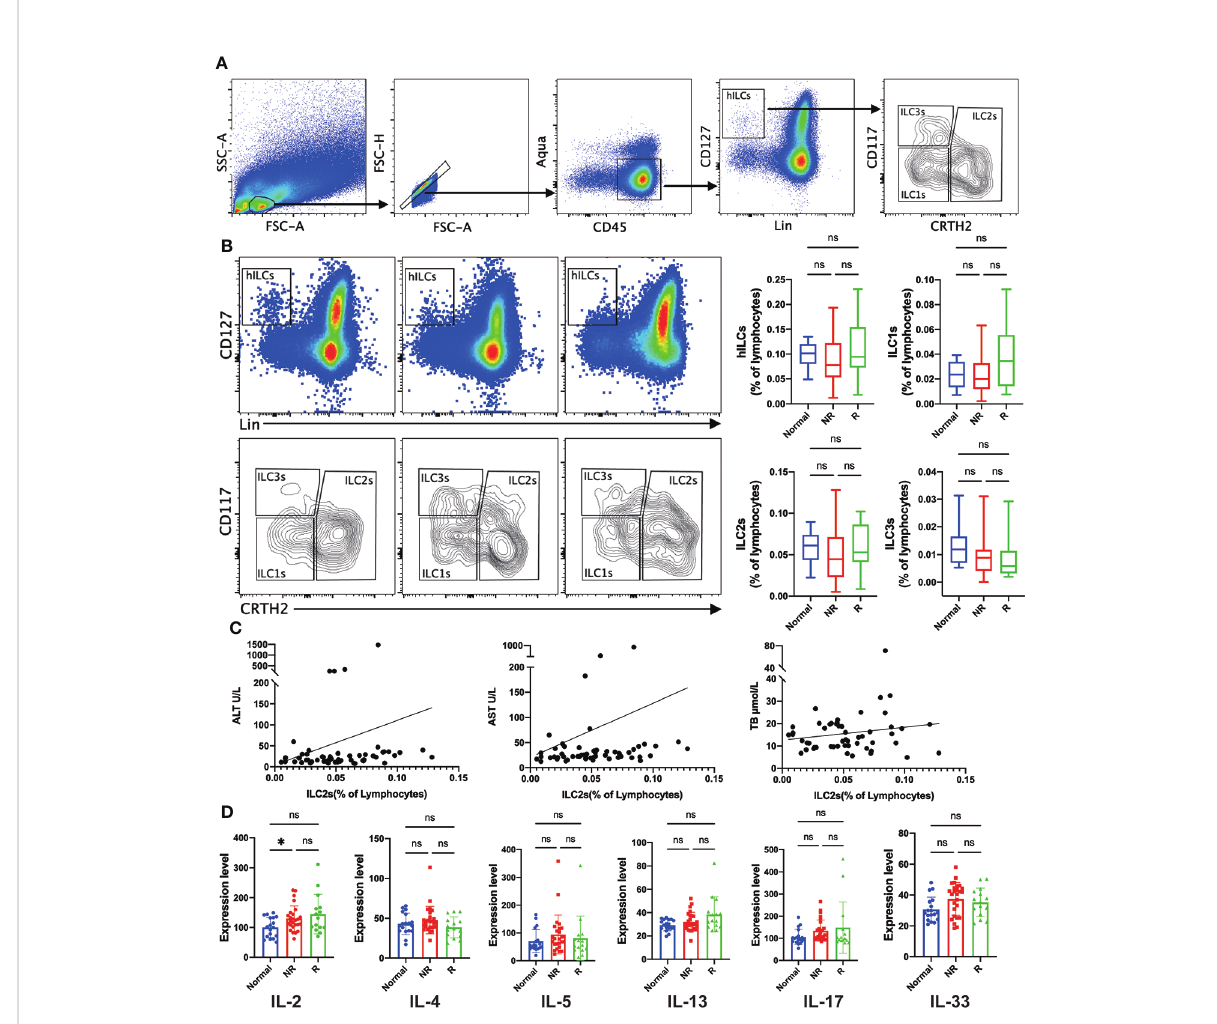
FIGURE 1 Similar frequencies of circulating helper innate lymphoid cells (hILCs), group 1 Innate lymphoid cells (ILC1s), group 2 Innate lymphoid cells (ILC2s), and group 3 Innate lymphoid cells (ILC3s) were detected in liver transplant recipients with either rejection or non-rejection compared with the control group. (A) The gating strategy to identify human hILC, ILC1s, ILC2s, and ILC3s in peripheral blood. (B) Representative fl ow cytometric analysis showed a similar frequency of circulating hILCs, ILC1s, ILC2s, and ILC3s were detected liver transplant recipients with either rejection or non-rejection compared with the control group. (C) Correlation analysis showed no correlations between the frequency of circulating ILC2s and the plasma levels of ALT, AST, and TB. (D) The plasma level of IL-2 was signi fi cantly increased in the non-rejection